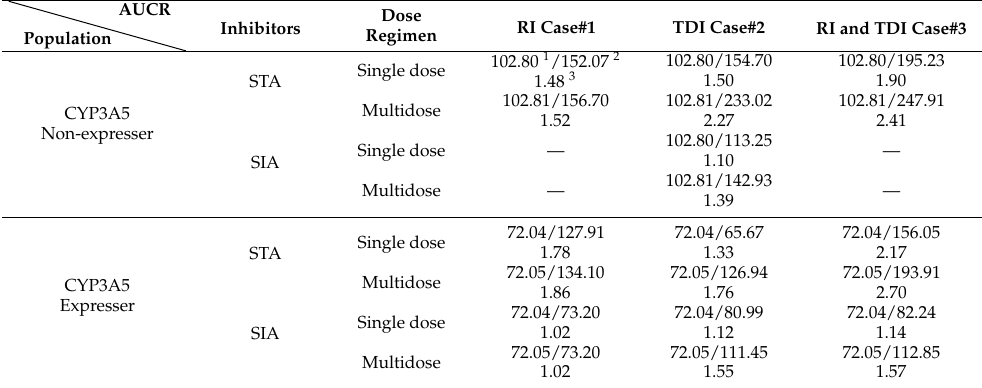
Table 2. Results of drug-drug interaction (DDI) prediction for single-dose and multidose of STA and SIA in CYP3A5 expressers and